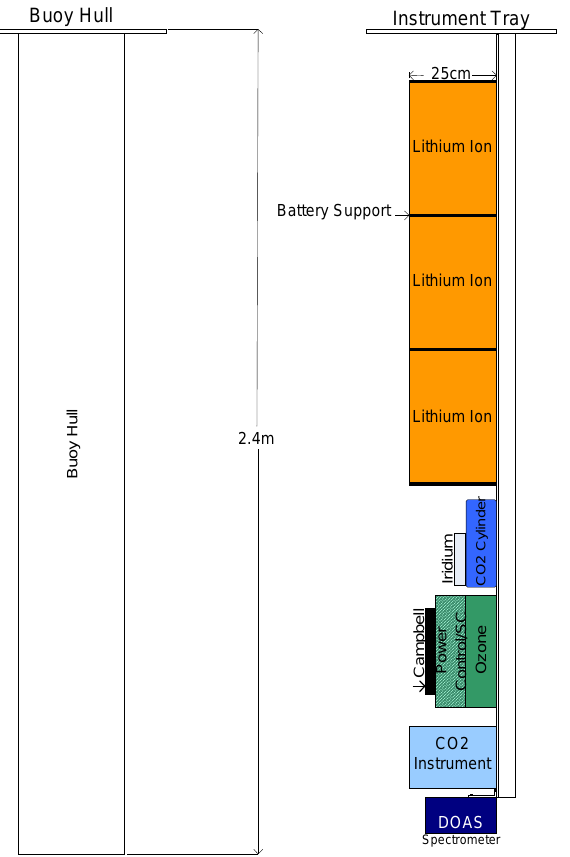
Fig. 1. Schematic drawing of the O-buoy hull and instrumentation placement on the instrument panel.